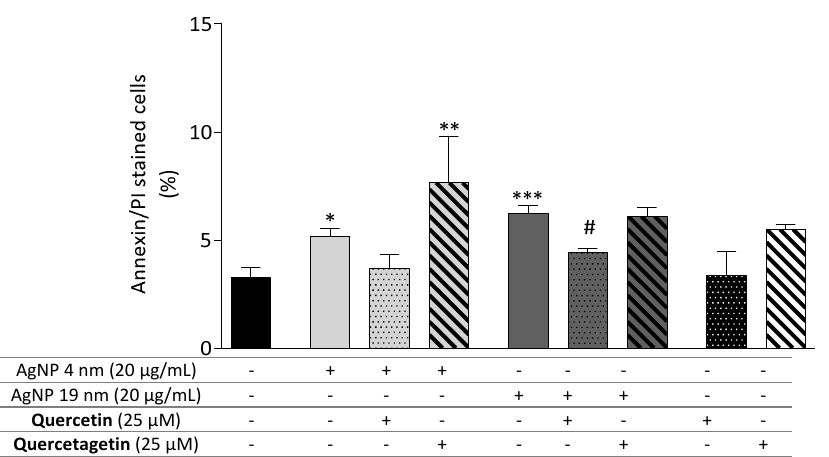
Figure 10. Effect of flavonoid co-incubation on apoptosis of Caco-2 cells exposed to an apoptotic concentration of AgNP. Cells were co-incubated for 24 h with 4 nm and 19 nm AgNP (20 µg/mL— apoptotic concentration) and flavonoids. Apoptotic and necrotic populations were quantified by flow cytometry with annexin V-FITC and PI. * p < 0.05, ** p < 0.01 and *** p < 0.001 when compared with the control (untreated cells). # p < 0.05 when compared with the respective AgNP-treated cells. Values are presented as the means ± SEM ( n ≥ 5).